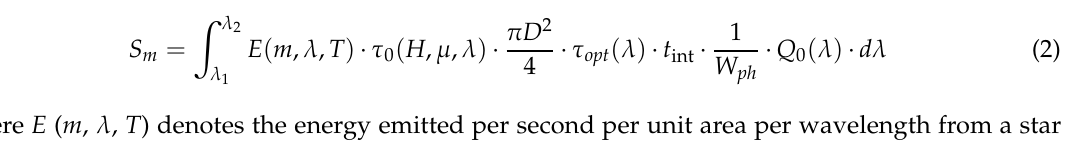
Figure 2. Numbers of stars of different temperatures in 2MASS with magnitudes less than 6.5.